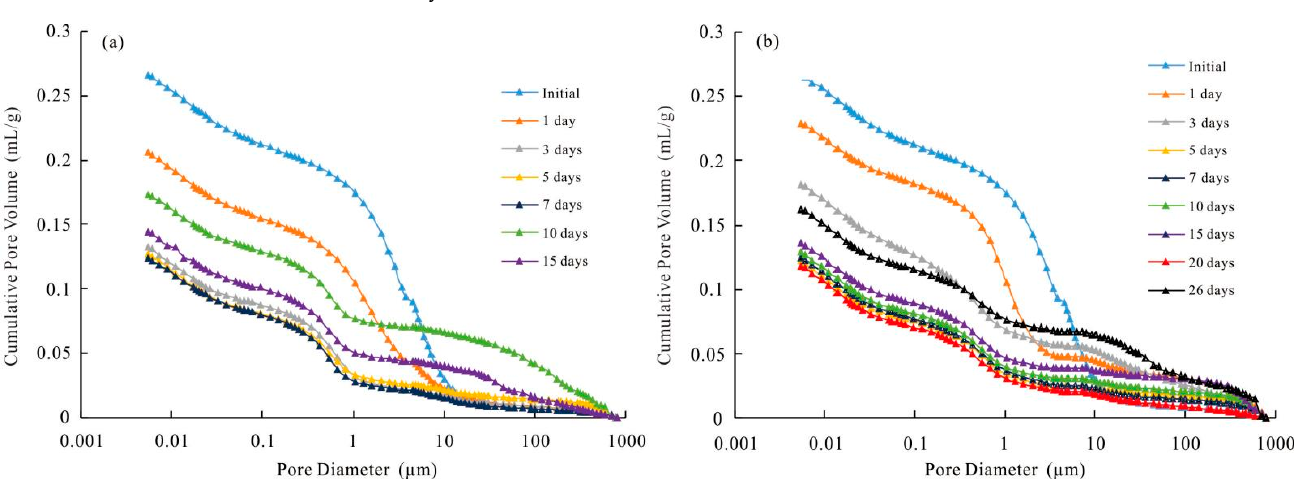
Figure 5. The relationship between the pore size distribution of expansive soil and the duration of dehydration under different environmental conditions ( a ) 50 °C-10%, ( b ) 50 °C-70%.